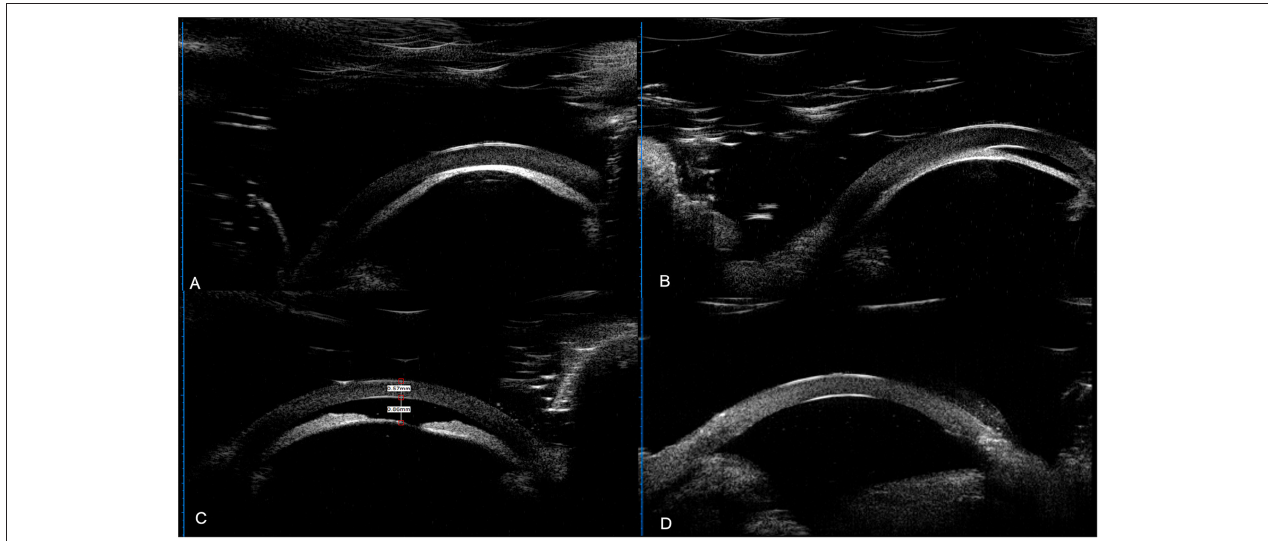
FIGURE 3 | UBM results of the patients. (A) UBM result of left eye of case 3 (a 3-month-old female’s); (B) UBM result of right eye of case 8 (a 5-month-old male). A&B: anterior lens displacement, iridocapsular adhesions, capsule-endothelial adhesion, corneal thickening and edema, and obliterated anterior chamber. (C,D) UBM result the right eye of case 15 (a 4-month-old male). (C) Preoperative UBM images showed shallowing of the AC with a depth of 0.86mm, and anterior lens displacement. (D) 7 months postoperatively, the AC was reconstructed with a depth of 3.2mm with AC angle open in this aphakic